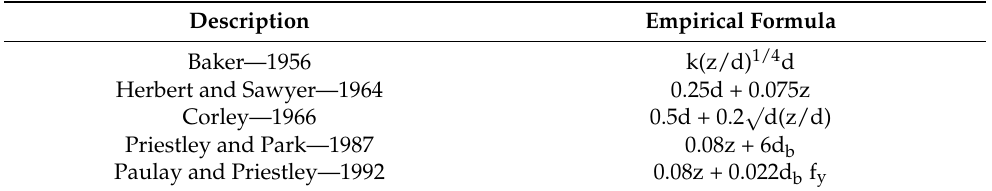
Table 1. Empirical formula to derive